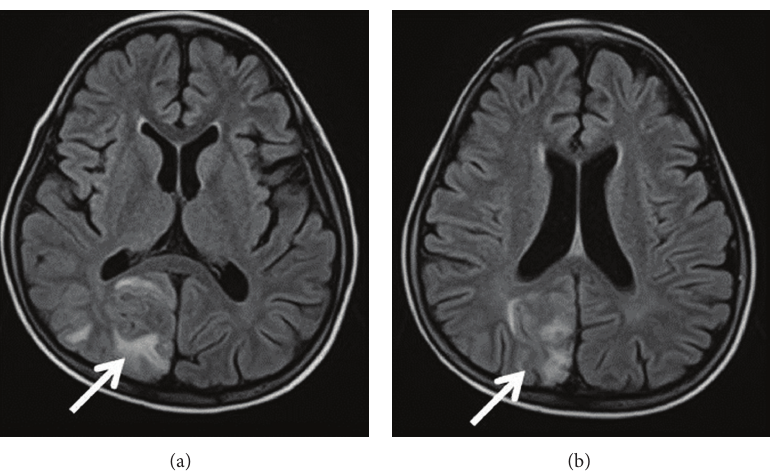
Figure 5: FLAIR brain MR images of a 12-year-old girl with sporadic paraganglioma admitted to our Institution with headache and seizures. Unilateral right occipitoparietal lobe vasogenic edema (arrows), typical of PRES, is well depicted after a severe hypertensive crisis. PRES = Posterior reversible encephalopathy